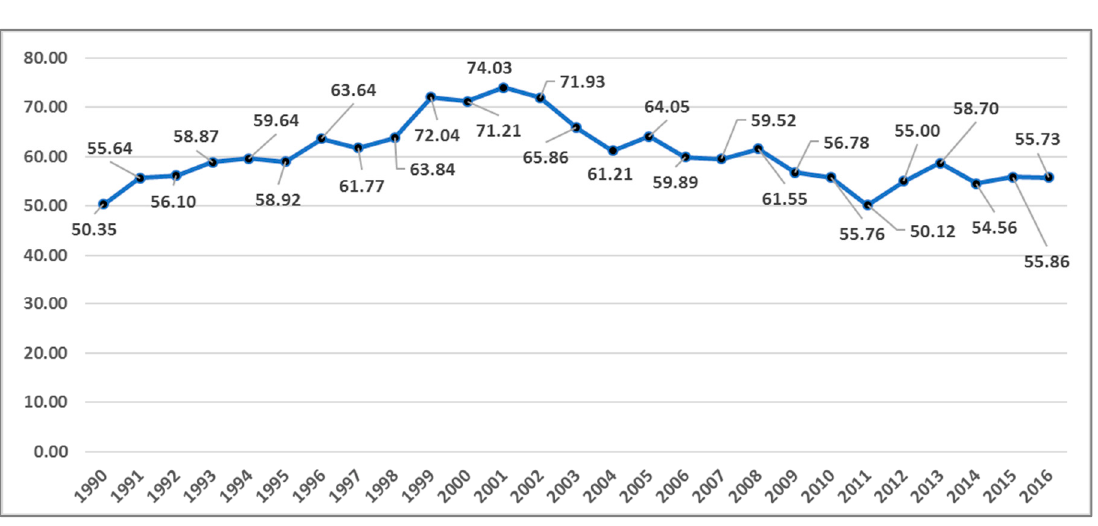
Figure 9. Percentage of Queensland’s share of national GHG emissions between 1990 and 2016 due to deforestation, derived from AGEIS [46].